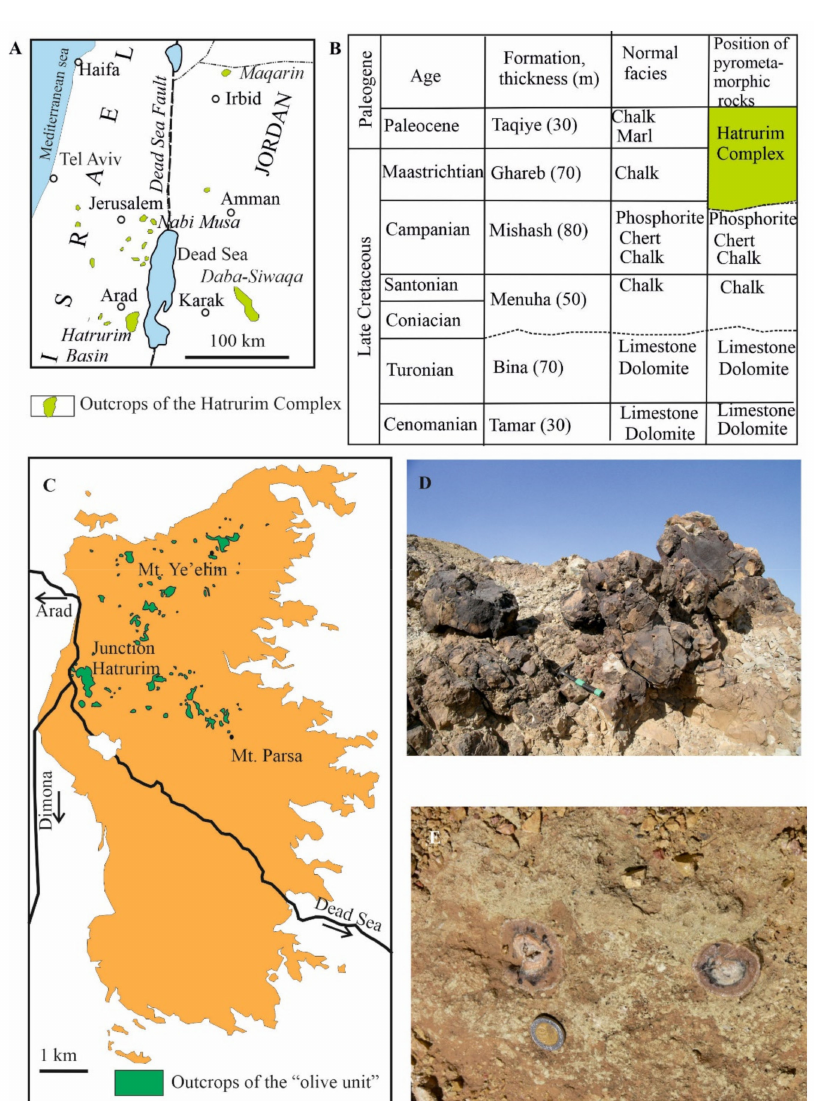
Figure 1. Geographical position of the study area. ( A )—Outcrops of the Hatrurim Complex in Israel and Jordan; ( B )—general schematic stratigraphic position of the Hatrurim Complex in the Late Cretaceous–Paleogene sequence of Israel [7,10]; ( C )—the outcrops of the “olive unit” in the Hatrurim Basin [11]. The schematic locality of Mt. Ye’elim is shown; ( D )—brecciated cliff of fresh anorthite–pyroxene hornfels, the “olive unit”. ( E )—Zeolite-bearing rock with typical zonal barite concretions. The size of coin is 2.25